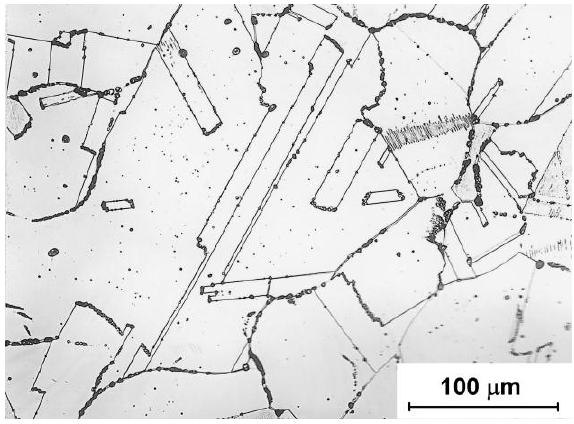
Figure 1. Microstructure of the 316L steel after solution annealing by regime 1050 °C/1 h/water.